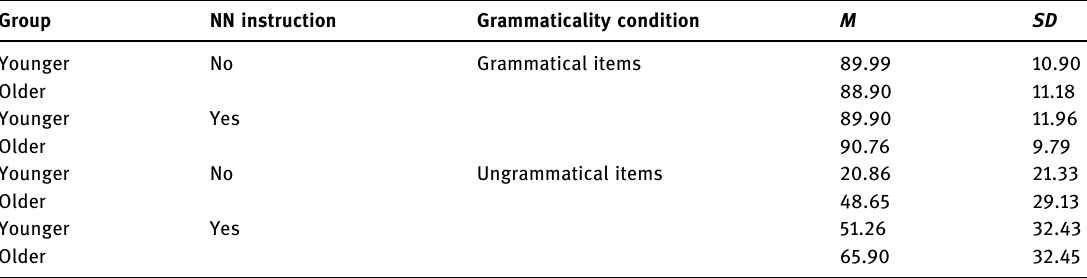
Table 4: Accuracy rates per NN instruction groups and grammaticality condition